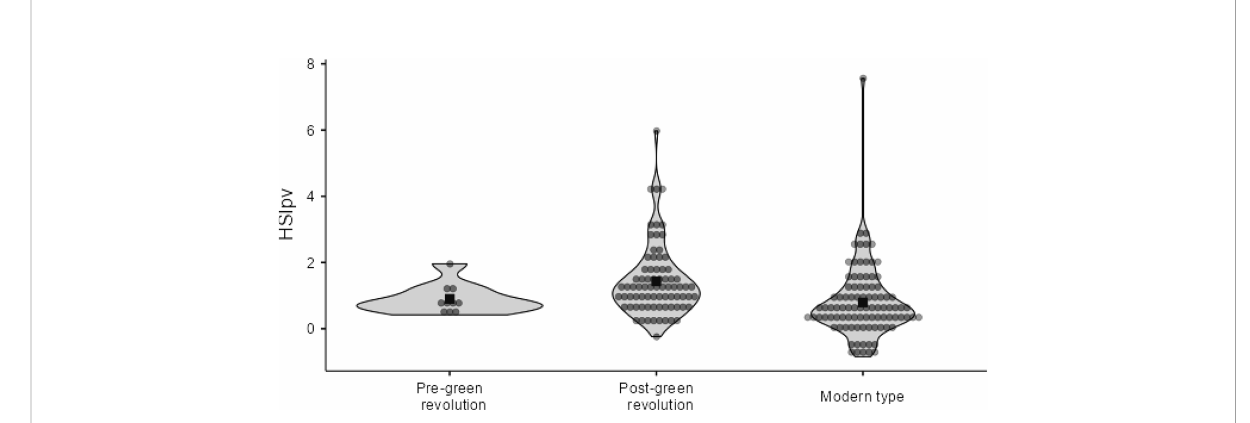
FIGURE 5 Violin plot showing the trend of HSI pv across pre-green revolution, post-green revolution, and modern wheat varieties.